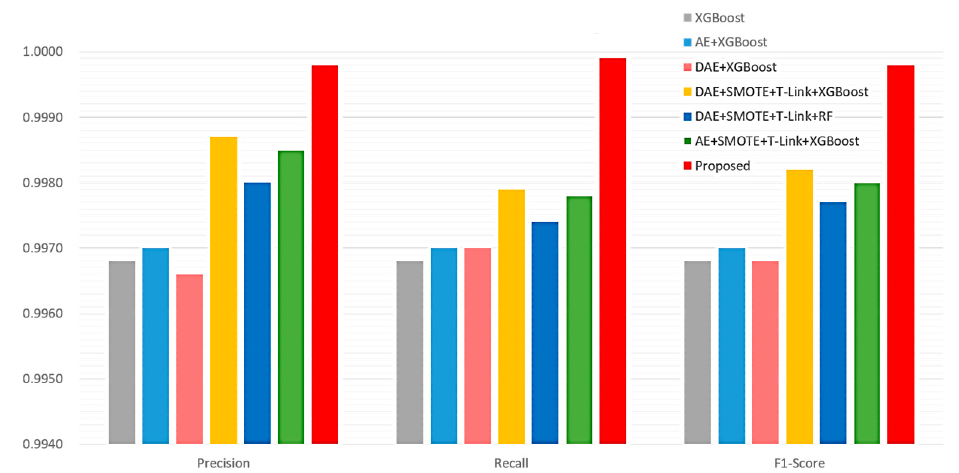
Figure 12. Performance comparisons of the proposed method and related ICS anomaly classification methods for the multi-class case. Table 3. Performance comparisons of the proposed method and the JC-AC method for the multi- class case.